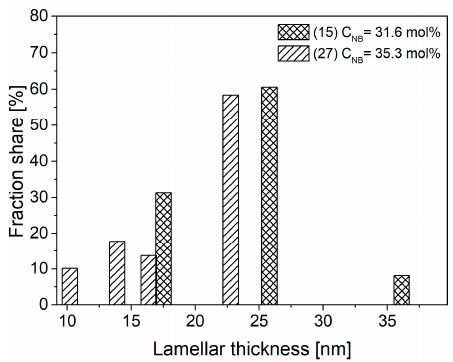
Figure 7. Distribution of lamellar thickness for E-NB copolymers obtained using the catalysts SIL / C4 and SIL / C6 (items according to Table 1).